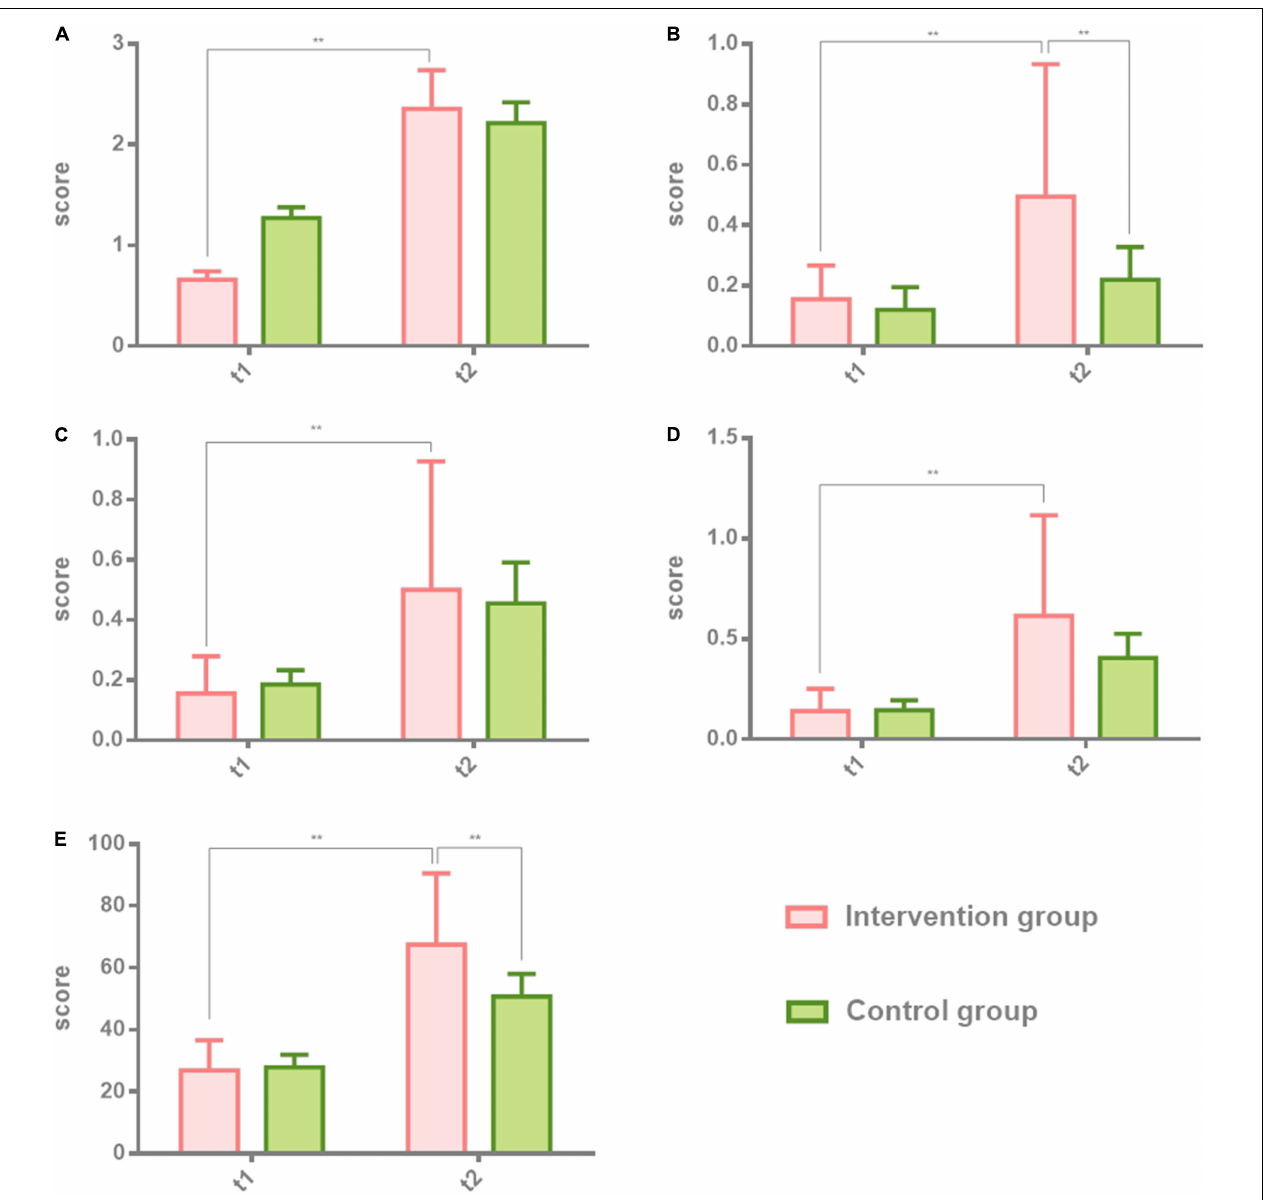
FIGURE 3 | Comparison of naming and aphasia quotient (AQ) in patients with non-fluent aphasia with the intervention group and the control group. The intervention group: melodic intonation therapy group; the control group: speech therapy group. (A–E) Objective naming, spontaneous naming, sentence completing, reaction naming, and AQ. Data are expressed as mean ± SD ( n = 20) and analyzed by repeated-measures analysis of variance. * p < 0.05, ** p < 0.01. t 1 , baseline; t 2 , after 8